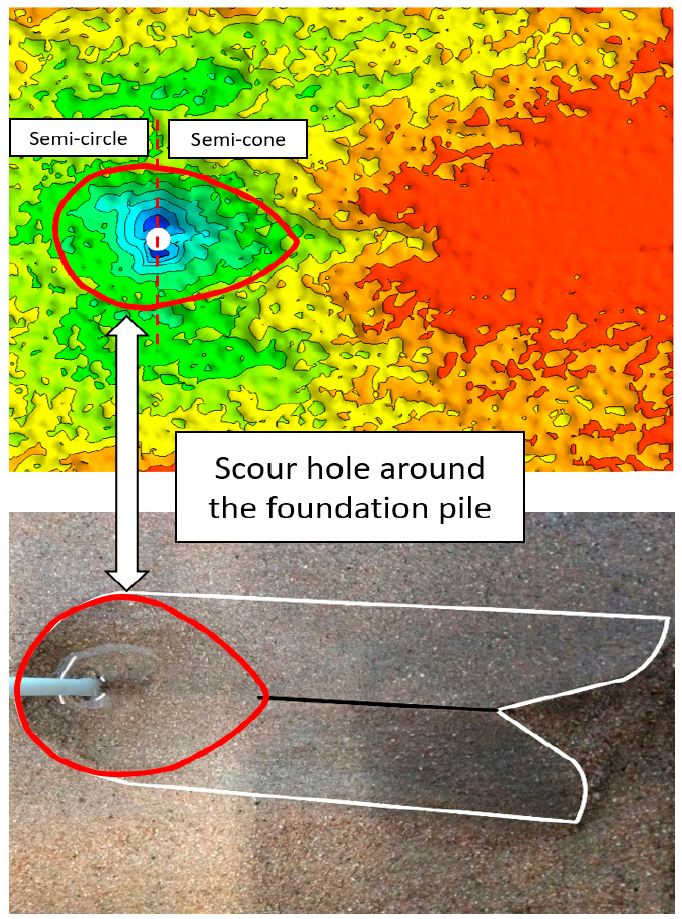
Figure 14. A comparison of equilibrium scour depth between the experiment and numerical simulations at different tip clearances.